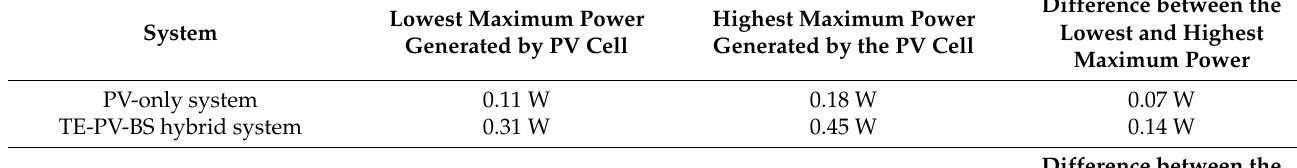
10 of 12 Table 1. Comparison of the maximum power generated by each system.